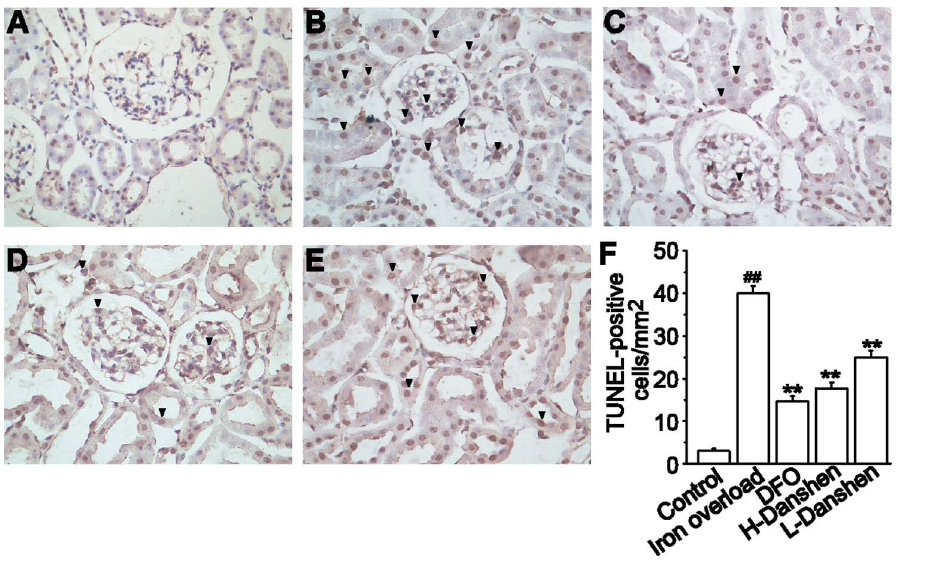
Figure 8. Effects of Danshen injection on apoptosis in kidneys. Representative microscopic photographs of TUNEL-stained kidney sections (black arrows) (magnification 400 6 ). Kidneys were obtained from the control (A), iron overload (B), DFO (C), H-Danshen (D) and L-Danshen (E) groups. (F) Scores for TUNEL-positive cells in the kidneys are shown. Data are presented as means 6 S.E.M of 15 animals per group. **P , 0.01, compared with iron overload group; ## P , 0.01, compared with control